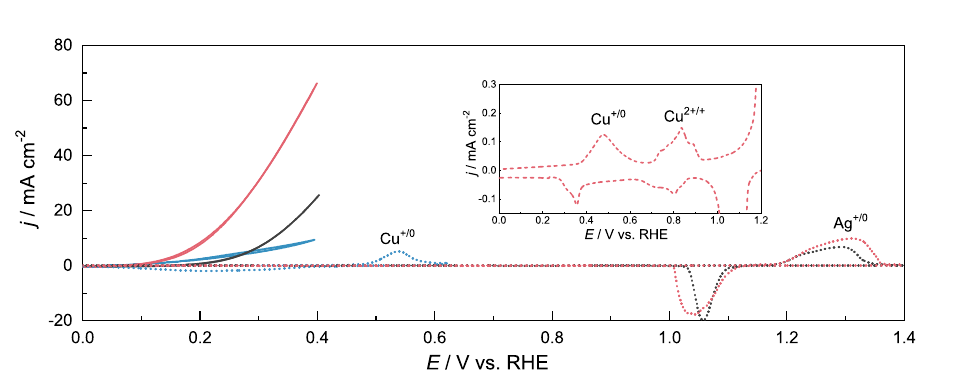
Fig. 1 | Schematic illustration of water electrolysis and HCHO electrooxidation. a Conventional electrocatalytic water splitting under alkaline conditions. b Electrocatalytic water reduction coupled with HCHO oxidation under alkaline conditions.